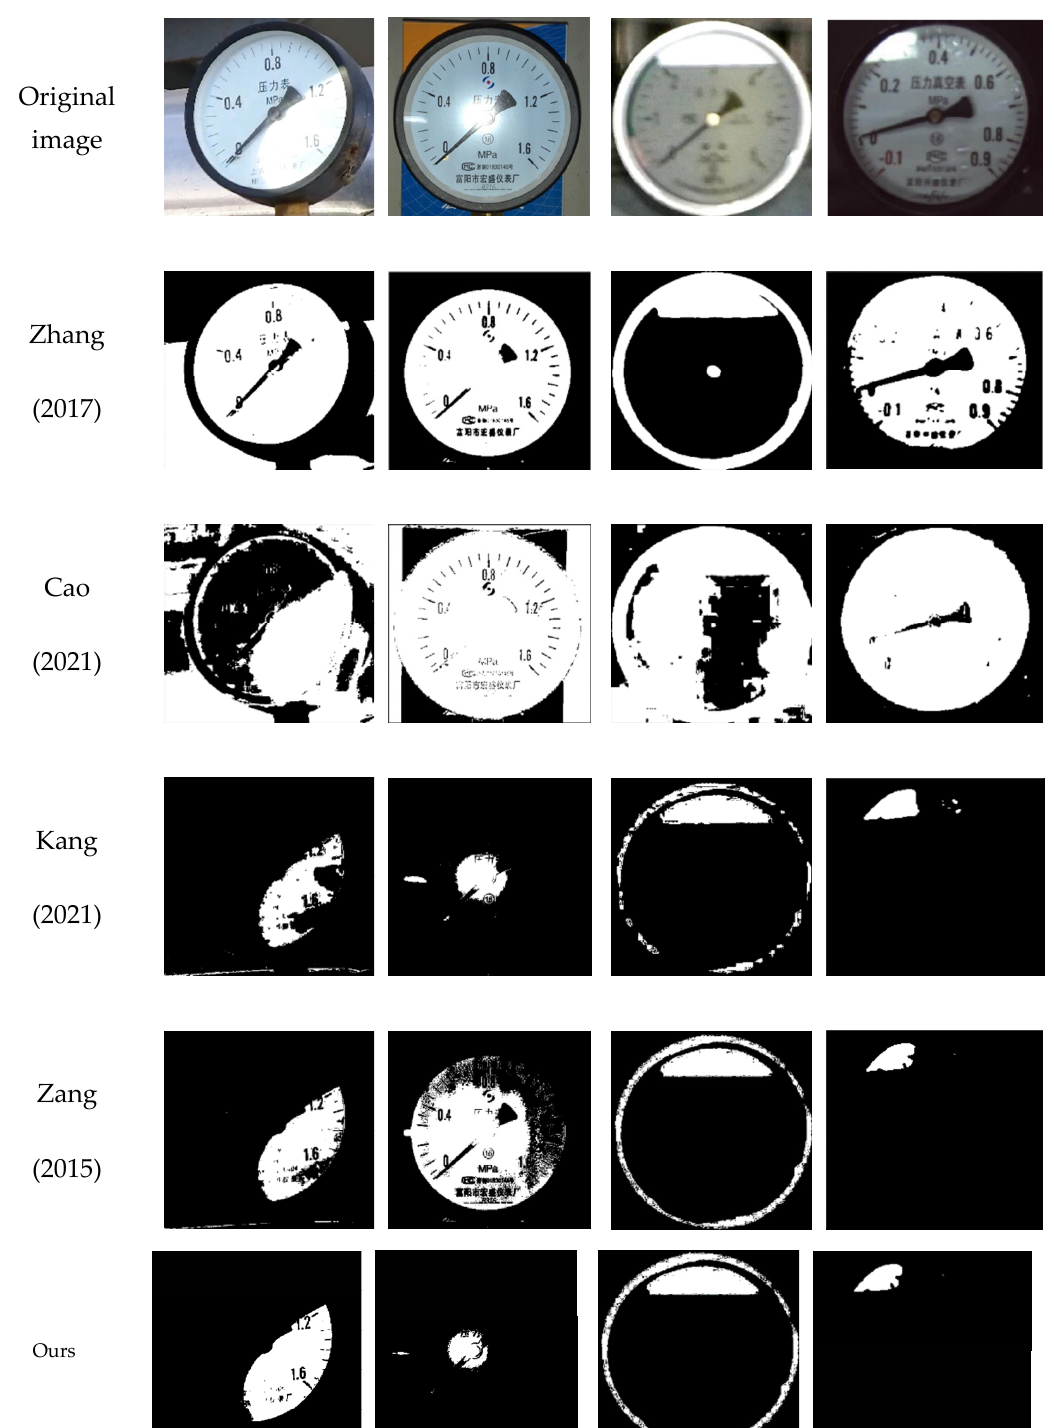
Figure 18. Reflective area detection results [11–13,24]. Table 1. Comparison of evaluation